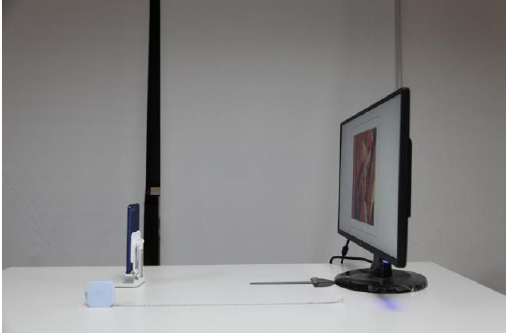
Figure 9. Experimental equipment for the screenshot process.